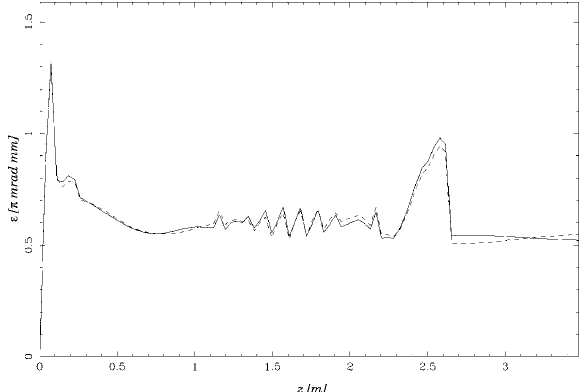
FIG. 3. Horizontal and vertical emittances obtained from ASTRA [6] simulations for the electron source up to position z just before the end of the